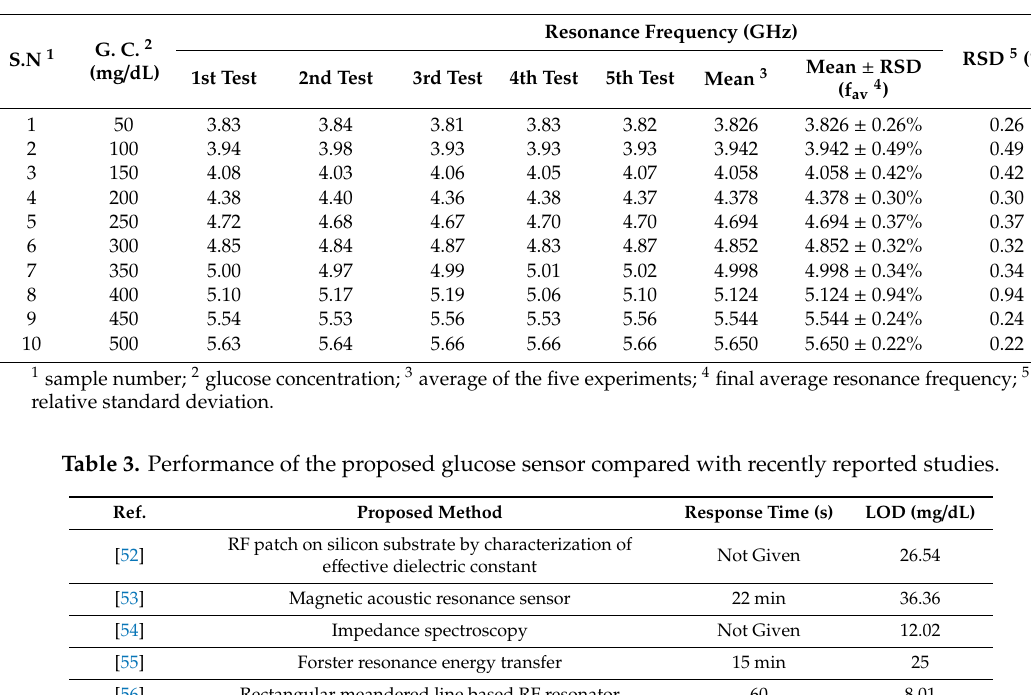
Table 2. Performances of the di ff erent measured resonance frequencies with various glucose concentrations ranging from 50 mg / dL to 500 mg / dL.